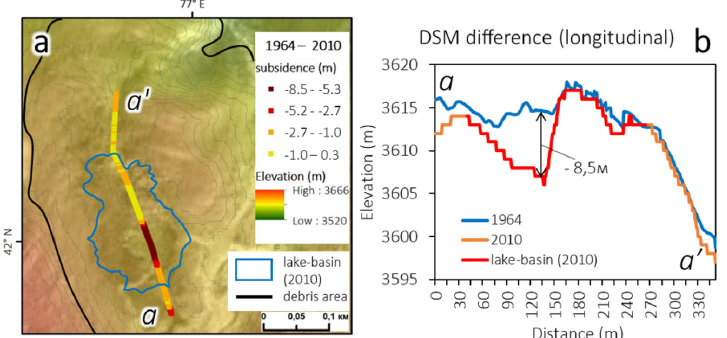
Figure 8. Surface elevations at the lake basin and moraine dam area in 1964 and 2010. ( a ) Digital surface model (DSM) di ff erences on the surface in the map and ( b ) longitudinal profile of the two DSMs along a–a (cid:48) . Profile location showed in Figure 1C. Data based on DSMs generated from Corona KH-4A, taken on 6 October 1964, and from ALOS, taken on 10 November